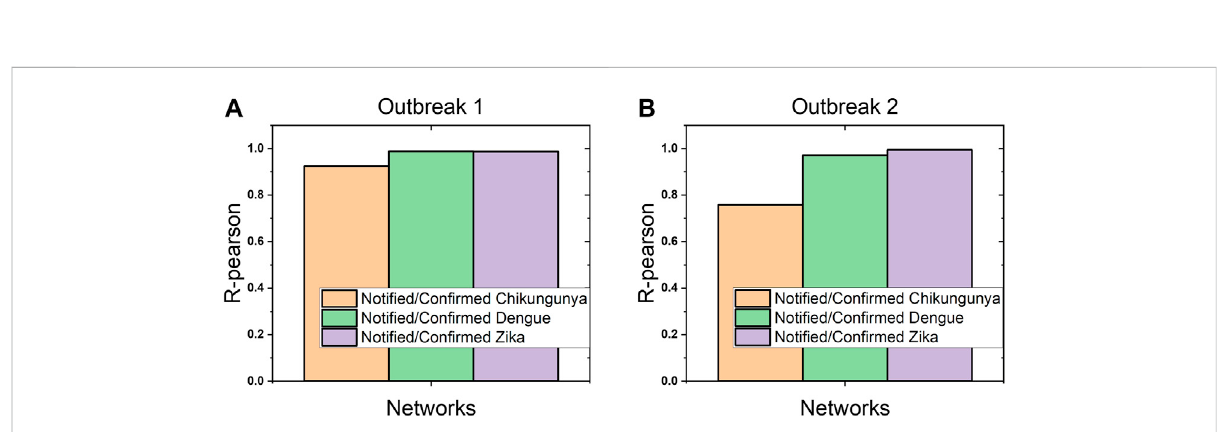
FIGURE 6 Pearson correlation coef fi cient (R-Pearson) of the temporal evolution of the average degree of the network of noti fi ed and con fi rmed. (A) Outbreak 1. (B) Outbreak